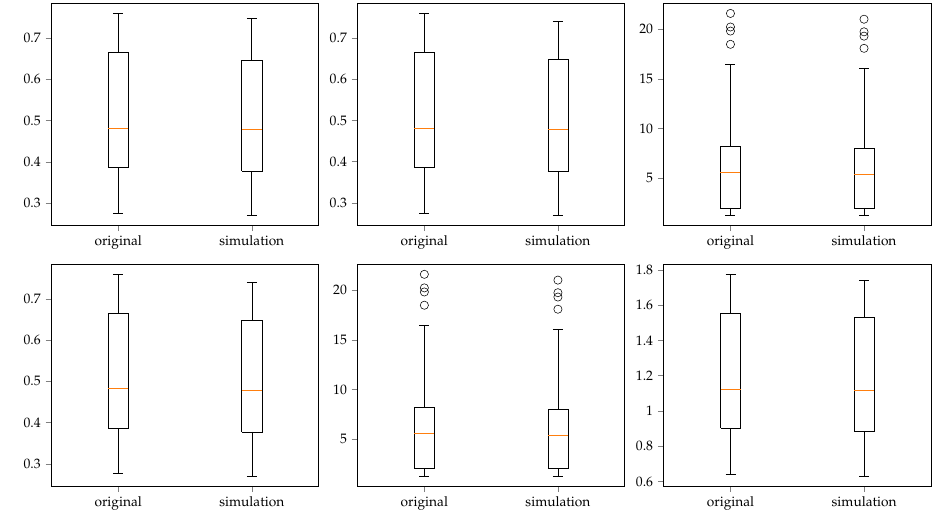
Figure A1. Generated test